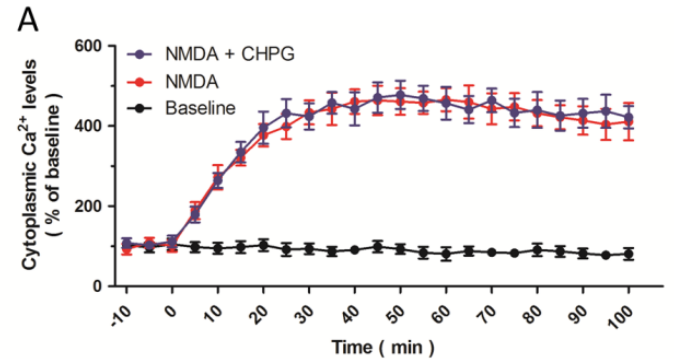
Figure 4. CHPG disrupts the formation of NMDAR-PSD-95 complex. Differentiated PC12 cells were treated with 100 μM NMDA alone or pretreated with 50 μM CHPG before NMDA treatment. ( A ) Cytoplasmic Ca 2+ levels were measured by calcium imaging up to 100 min after injury; ( B , C ) Coimmunoprecipitation experiments showed the effects of CHPG on NMDAR-PSD-95 interaction. Samples were immunoprecipitated and analyzed by western blotting with the indicated antibodies and the data was analyzed. Data represent means ± SD from five experiments. * p < 0.05 vs. control group and # p < 0.05 vs. cells treated only with